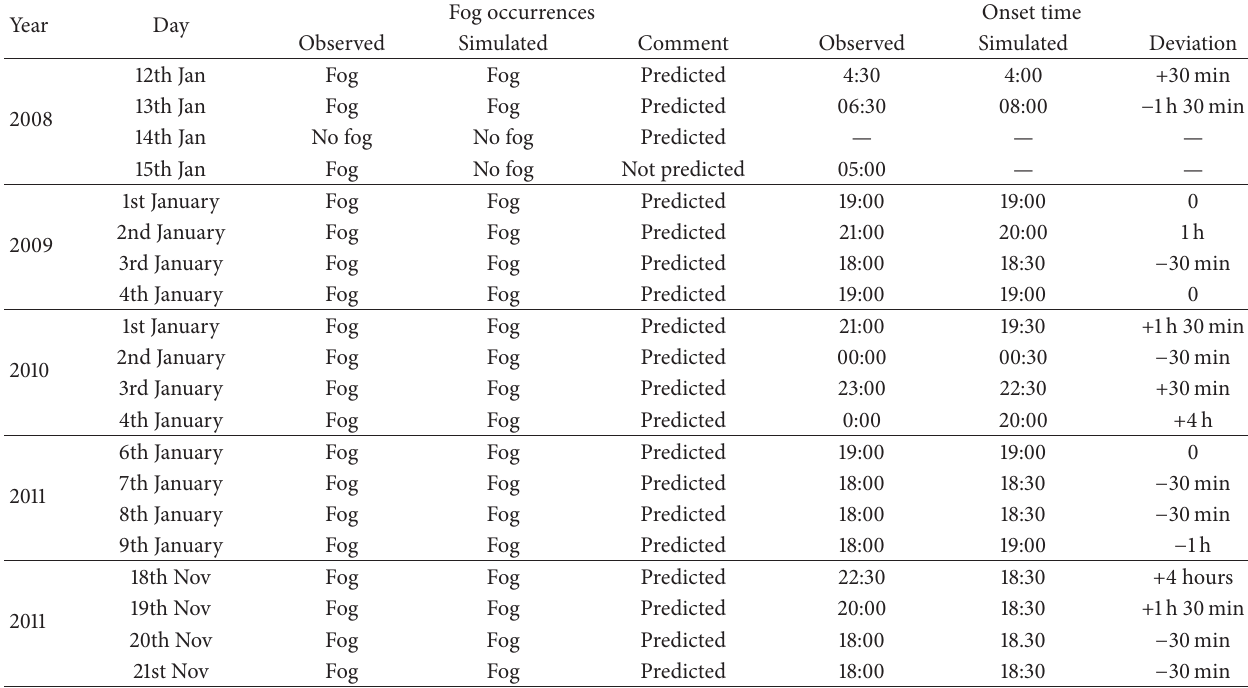
Table 3: Comparison of fog occurrence and observed